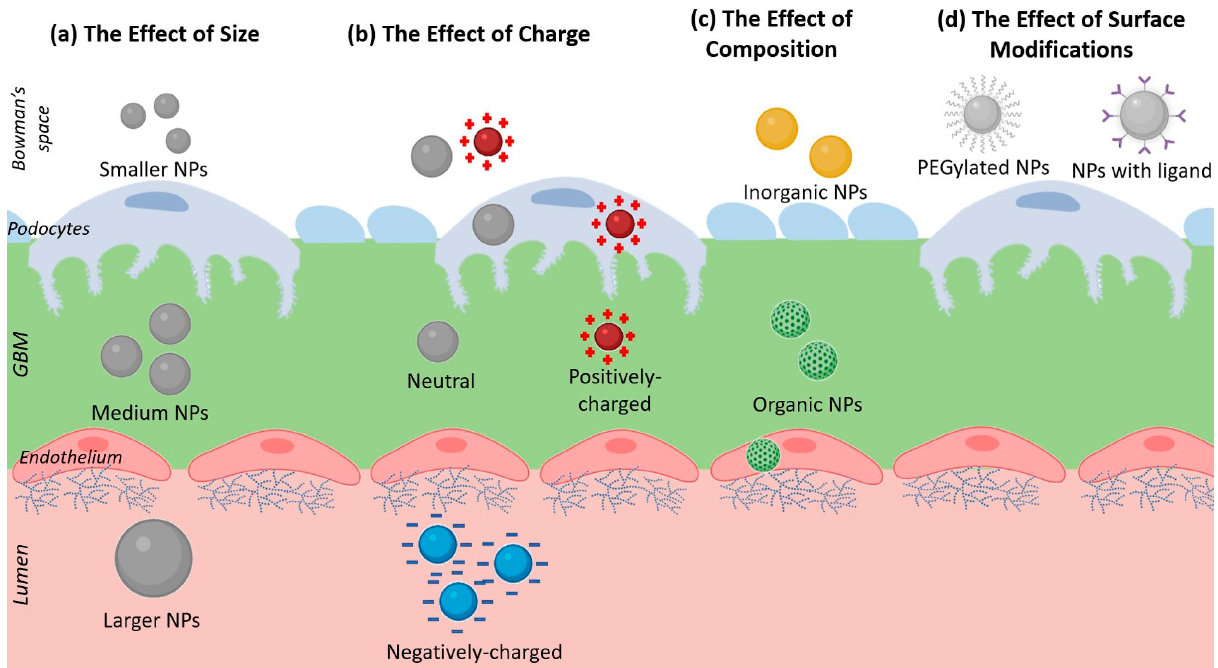
Figure 4. A diagram showing the 4 main factors which may give NPs the ability to bypass the GFB: ( a ) Size, showing NPs of different diameters. ( b ) Charge, showing NPs with different electrical charges. ( c ) Composition, showing organic and inorganic NPs. ( d ) Surface modifications, showing PEGylated NPs and NPs with ligand functionalization.